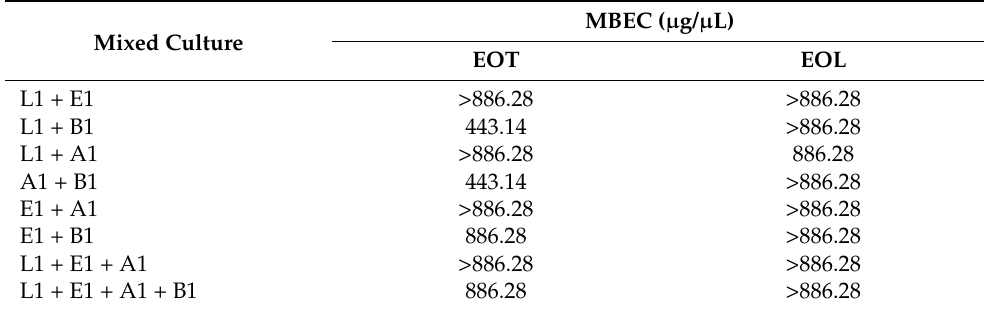
Table 8. Minimum biofilm eradication concentration (MBEC) against mixed cultures. Mixed